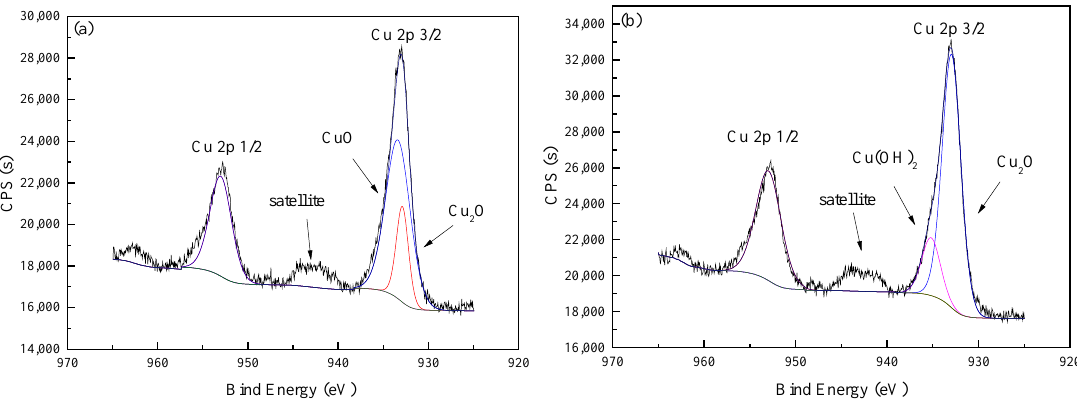
Figure 4. XPS spectra of the CuO /γ -Al 2 O 3 catalyst before and after discharge: ( a ) before; ( b ) after.